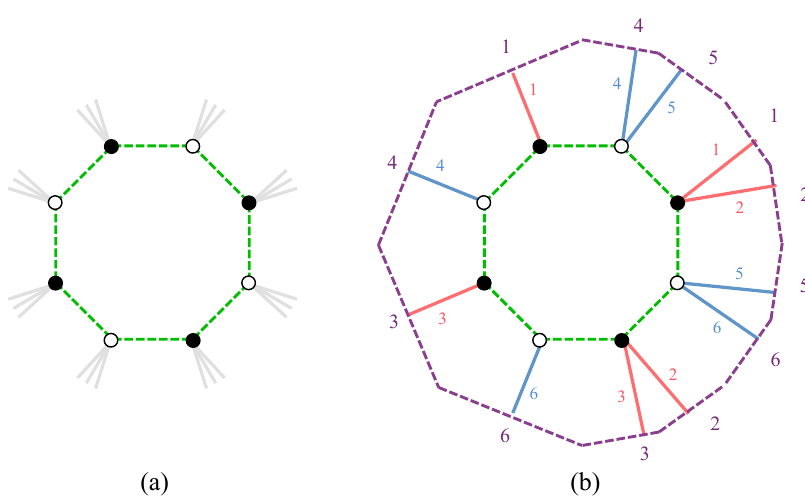
Figure 25. a) Part of the dimer that remains on the original Riemann surface. b) The new edges live on the genus k 1 = 3 handle. Both surfaces have matching holes. They are glued along the (cid:0) boundaries, which are shown in